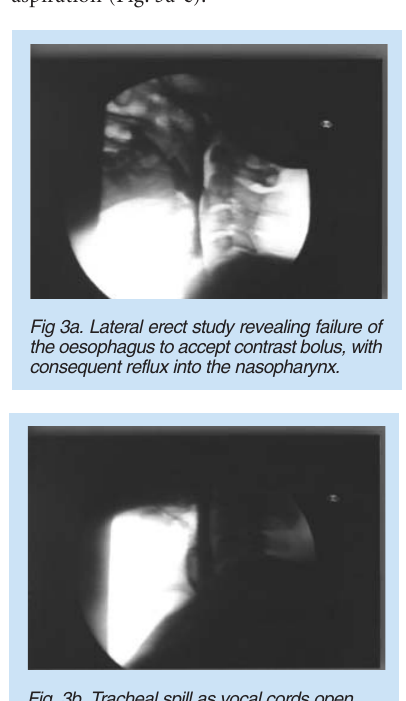
Fig. 3b. Tracheal spill as vocal cords open.